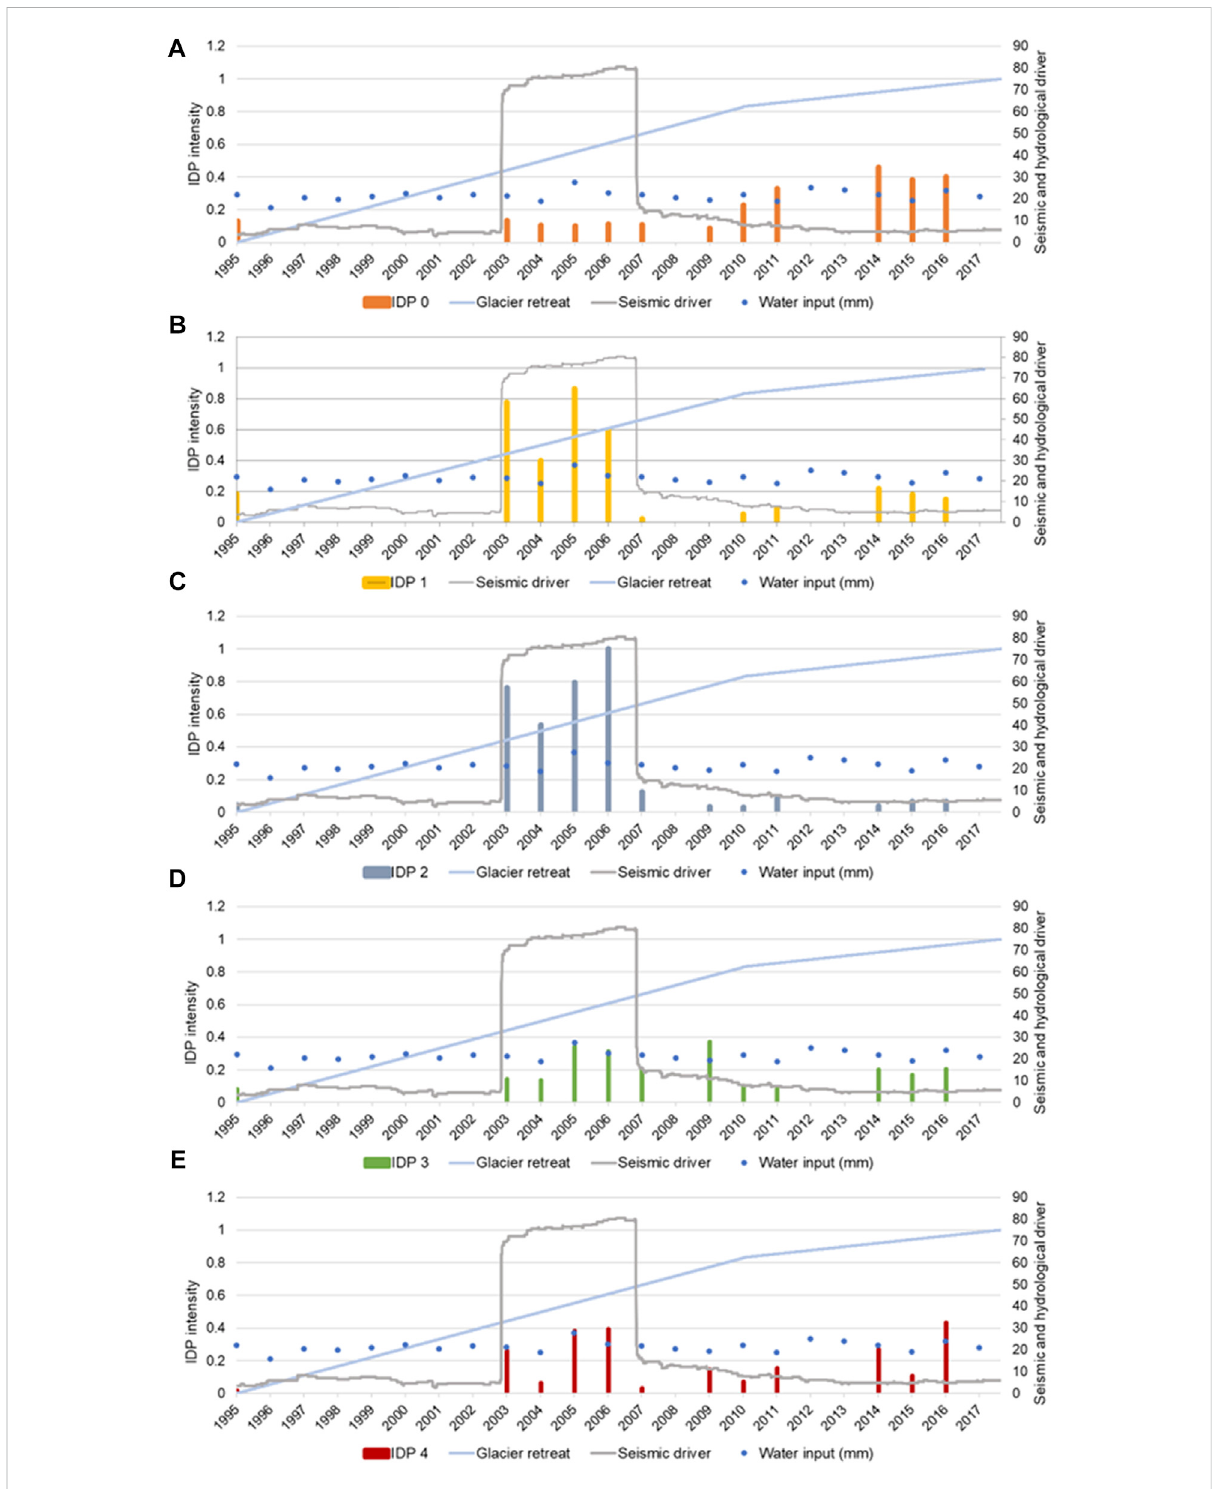
FIGURE 14 Independent deformation pattern intensities and their respective driver series for IDP0 to IDP4 [ (A – E) respectively].